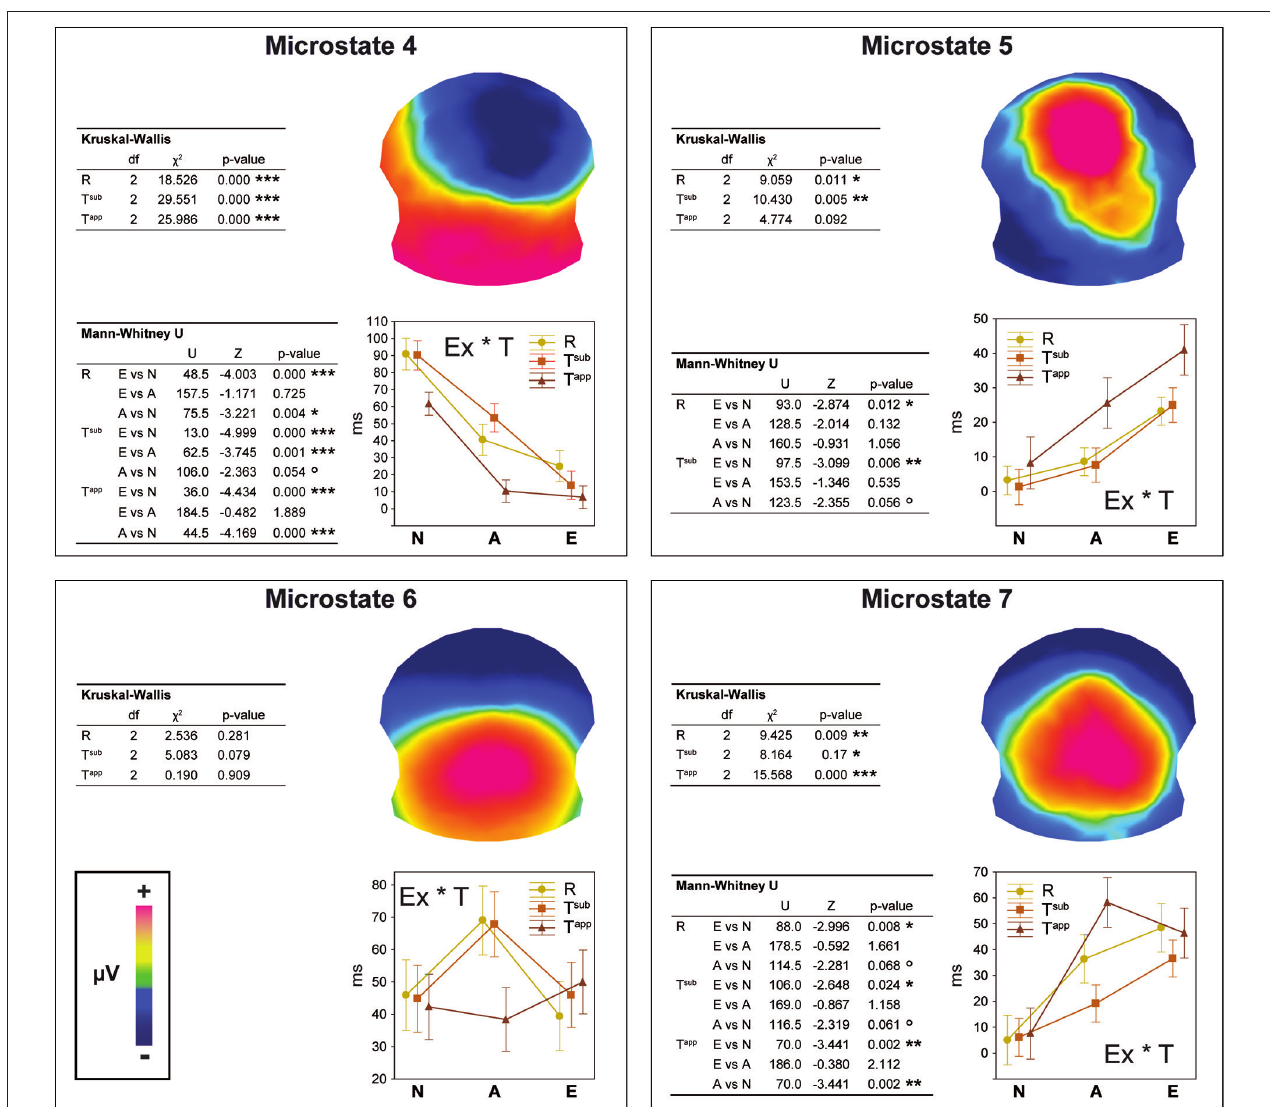
FIGURE 5 | Results of the fitting procedure. Mean duration (in ms) of microstates 4, 5, 6, and 7 compared by means of Kruskal-Wallis ANOVAs between Expertise groups and Transgression conditions for the 295–480ms period deriving from the spatio-temporal ERP analysis ( Figure 4 ). Additional Bonferroni corrected contrasts using Mann-Whitney U -tests are shown in the left bottom table for each microstate. The Expertise groups for each Transgression Condition are compared in the case of significant ANOVA results only.